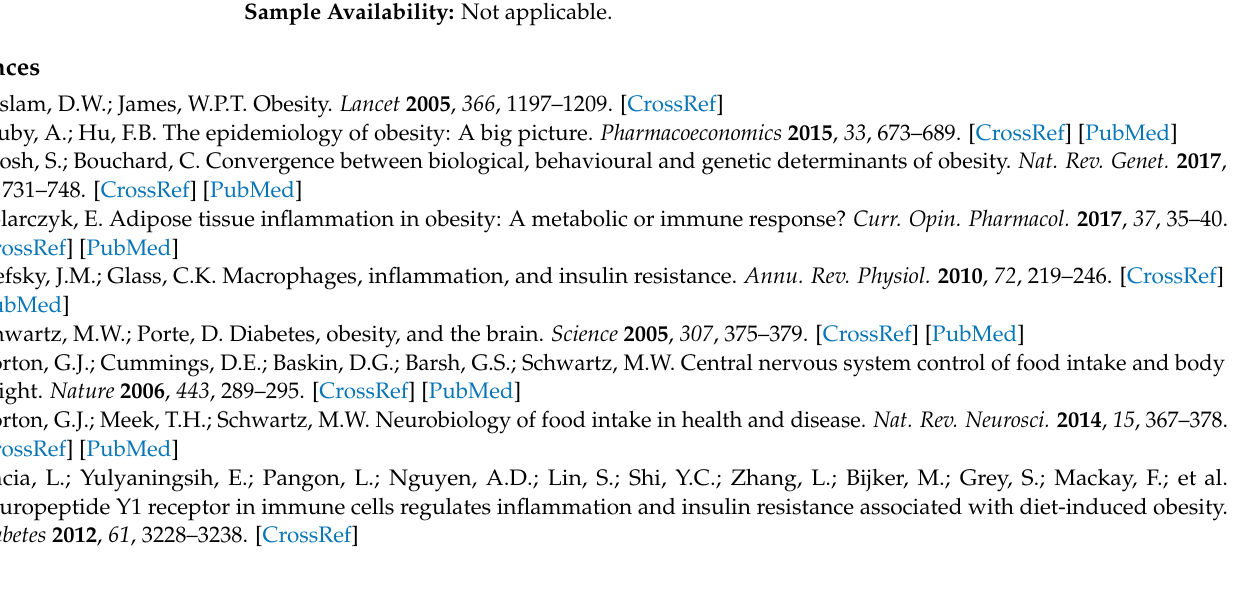
Supplementary Materials: Figure S1: Intensity of Npgl overexpression at the experimental endpoint in the mediobasal hypothalamus of mice fed a high-fat diet (60% calories from fat). These mice were injected with an adeno-associated virus (AAV) vector, either a con-trol (AAV-CTL) or a